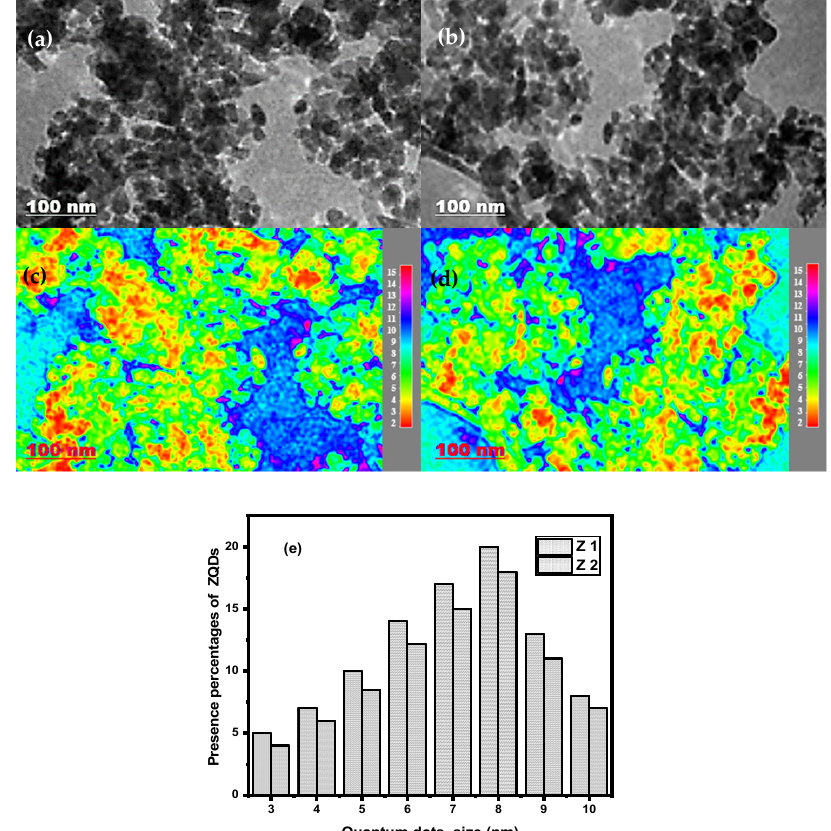
Figure 2. TEM image of different prepared ZQDs samples ( a , b ) along with their corresponding particle size distribution map ( c , d ) and presence percentages of ZQDs ( e ).